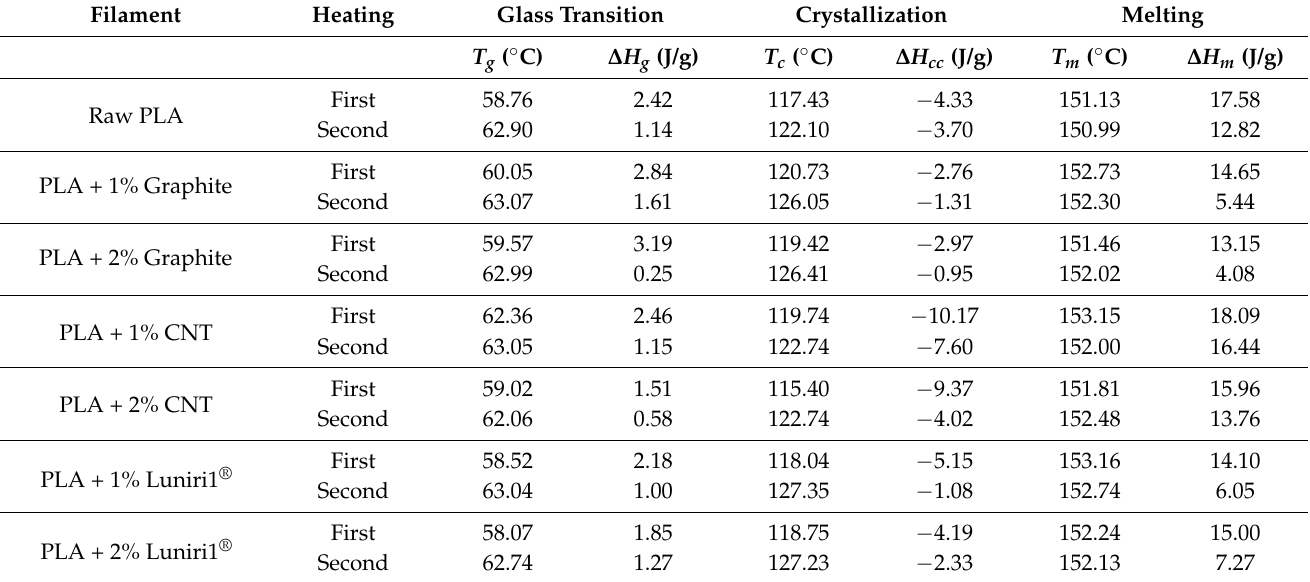
Table 5. DSC results of PLA based filaments.